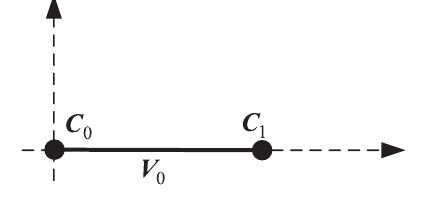
Fig. 5 Determine the initial B-spline control vector.